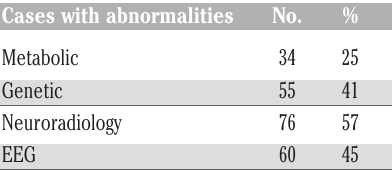
Table 1. Underlying etiology in global developmental delay.